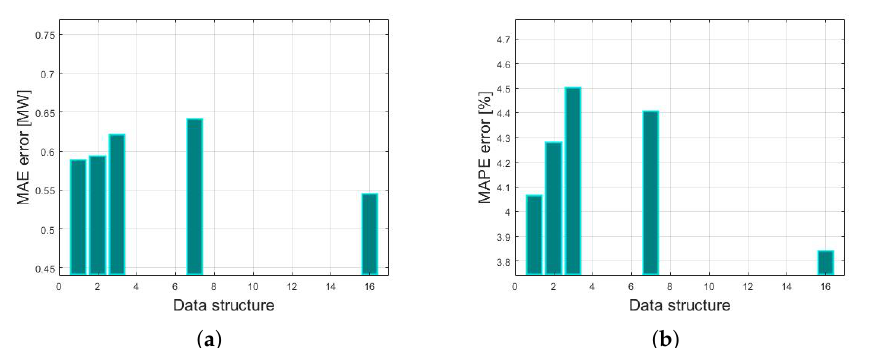
Figure 25. Summary of forecast accuracies by the selected data structure for wind power plant FW3. ( a ) MAE. ( b ) MAPE.